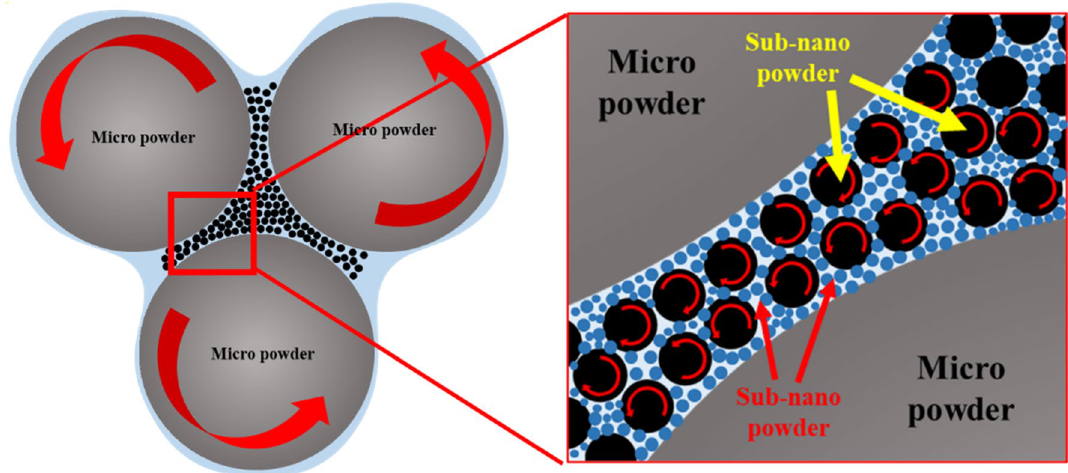
Figure 1. Schematic diagram showing rolling bearing effect among micro-sized, sub nano-sized, and nano- sized